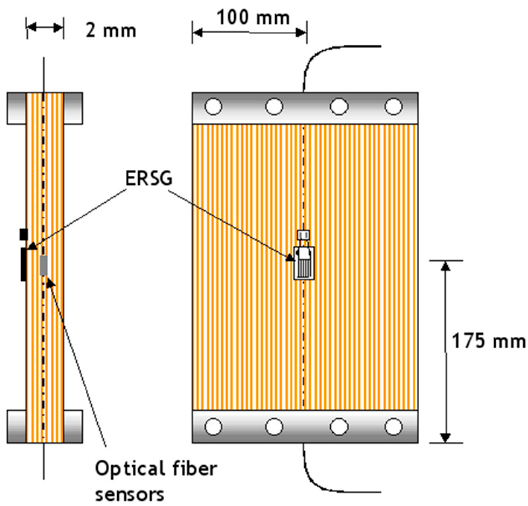
Figure 12. Side and plan-views of the relative locations of the surface-mounted electrical resistance strain gauges and the embedded optical fibre sensors.